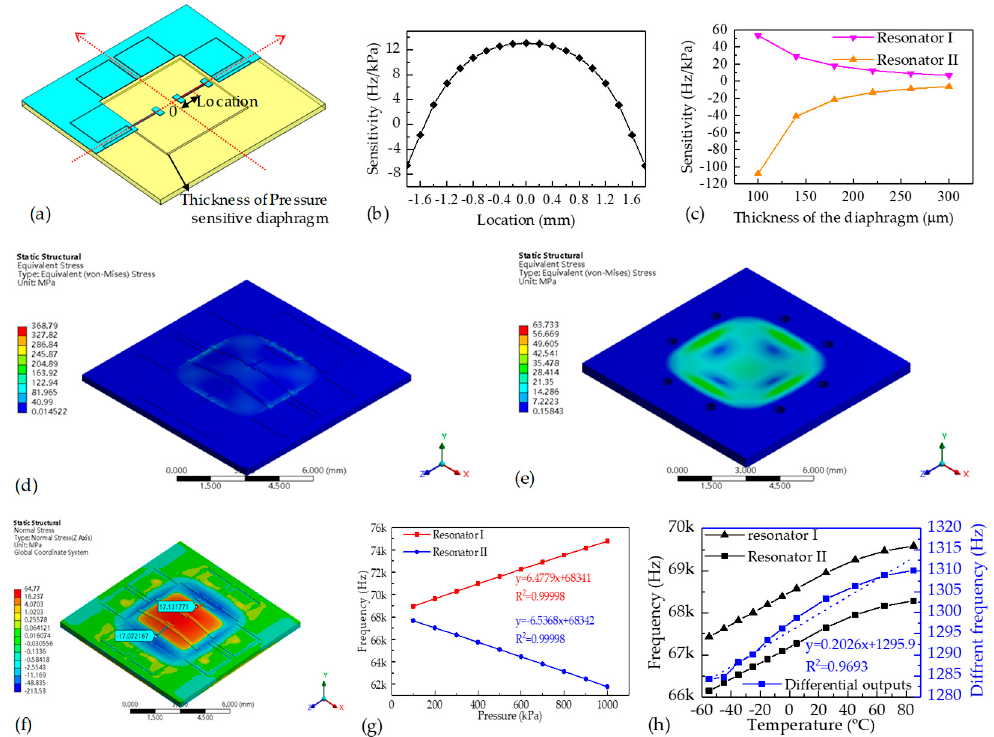
Figure 2. ( a ) The established geometry using in simulations; ( b ) The sensitivity variances in response to ( b ) resonator locations and ( c ) the thickness of the pressure-sensitive diaphragm. The equivalent stress distributions in ( d ) the SOI layer and ( e ) in the glass cap with a pressure of 1 MPa applied. ( f ) The normal stress distributions along the axial direction of the resonator with a pressure of 1 MPa applied. ( g ) The intrinsic frequency responses to applied pressure. ( h ) The intrinsic frequency responses to applied temperature.